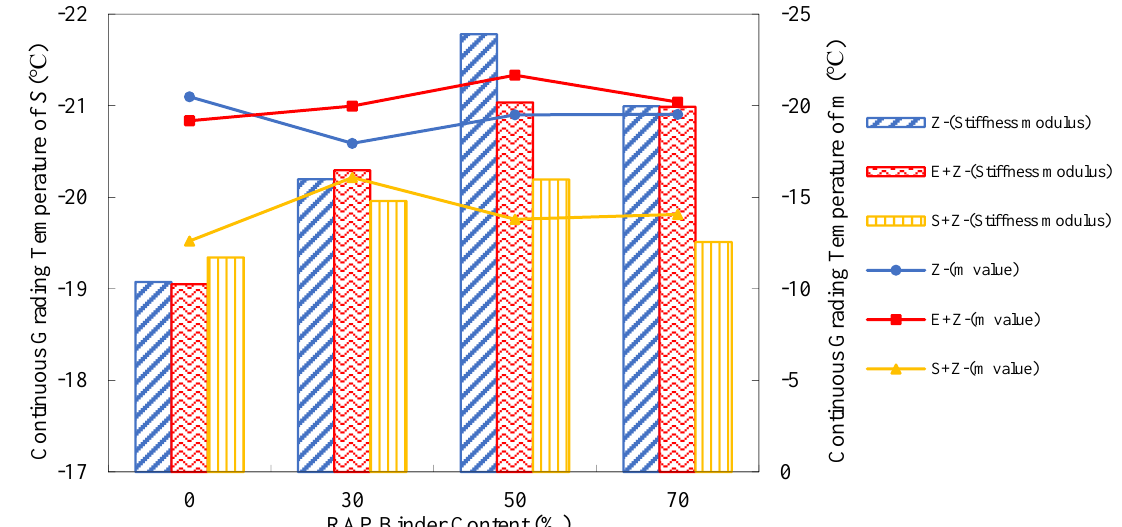
Figure 15. Low-temperature continuous grading temperatures of the warm-mix recycled binders at different RAP binder contents.